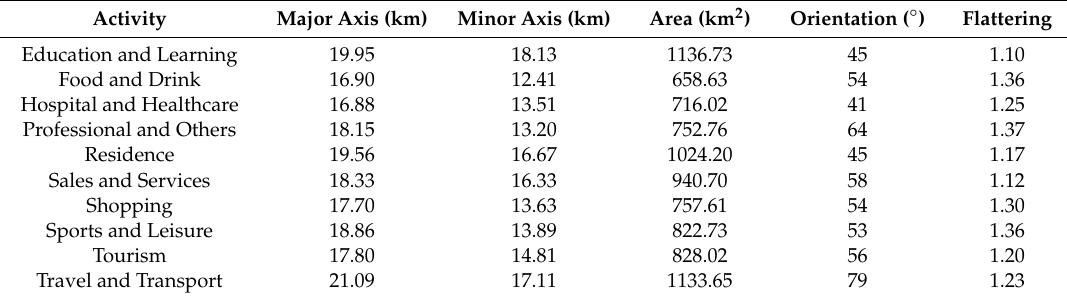
Figure 17. Standard deviational ellipses (SDEs) for activities in Shanghai. Table 6. SDE features on the major axis, minor axis, area, azimuth, and flattering for activities in Shanghai.